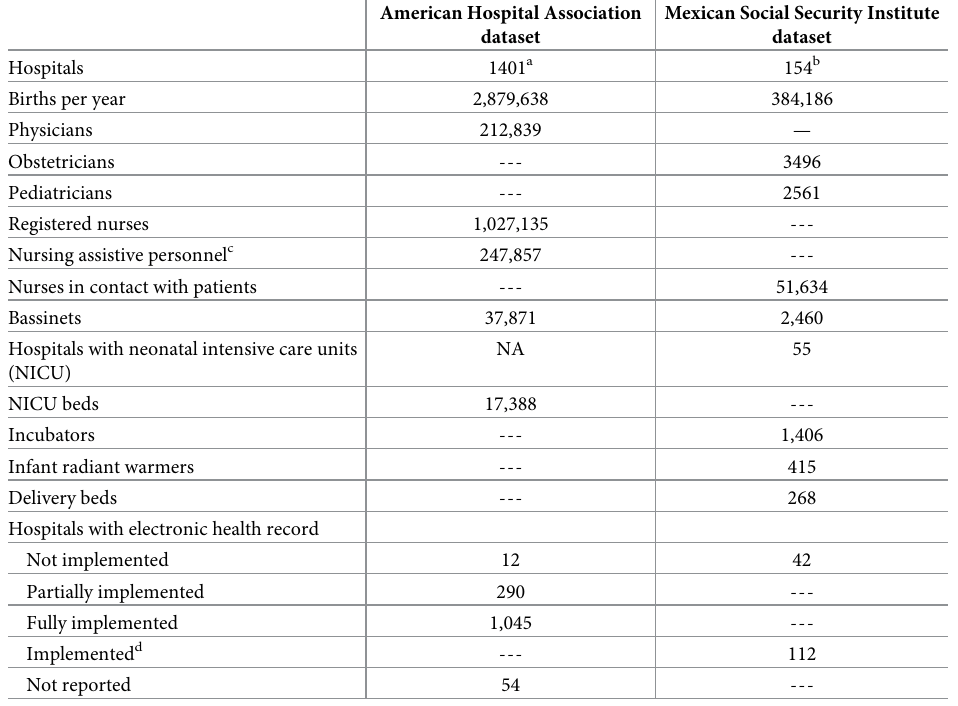
Table 2. Descriptive characteristics of the hospitals in the BFHI training costing